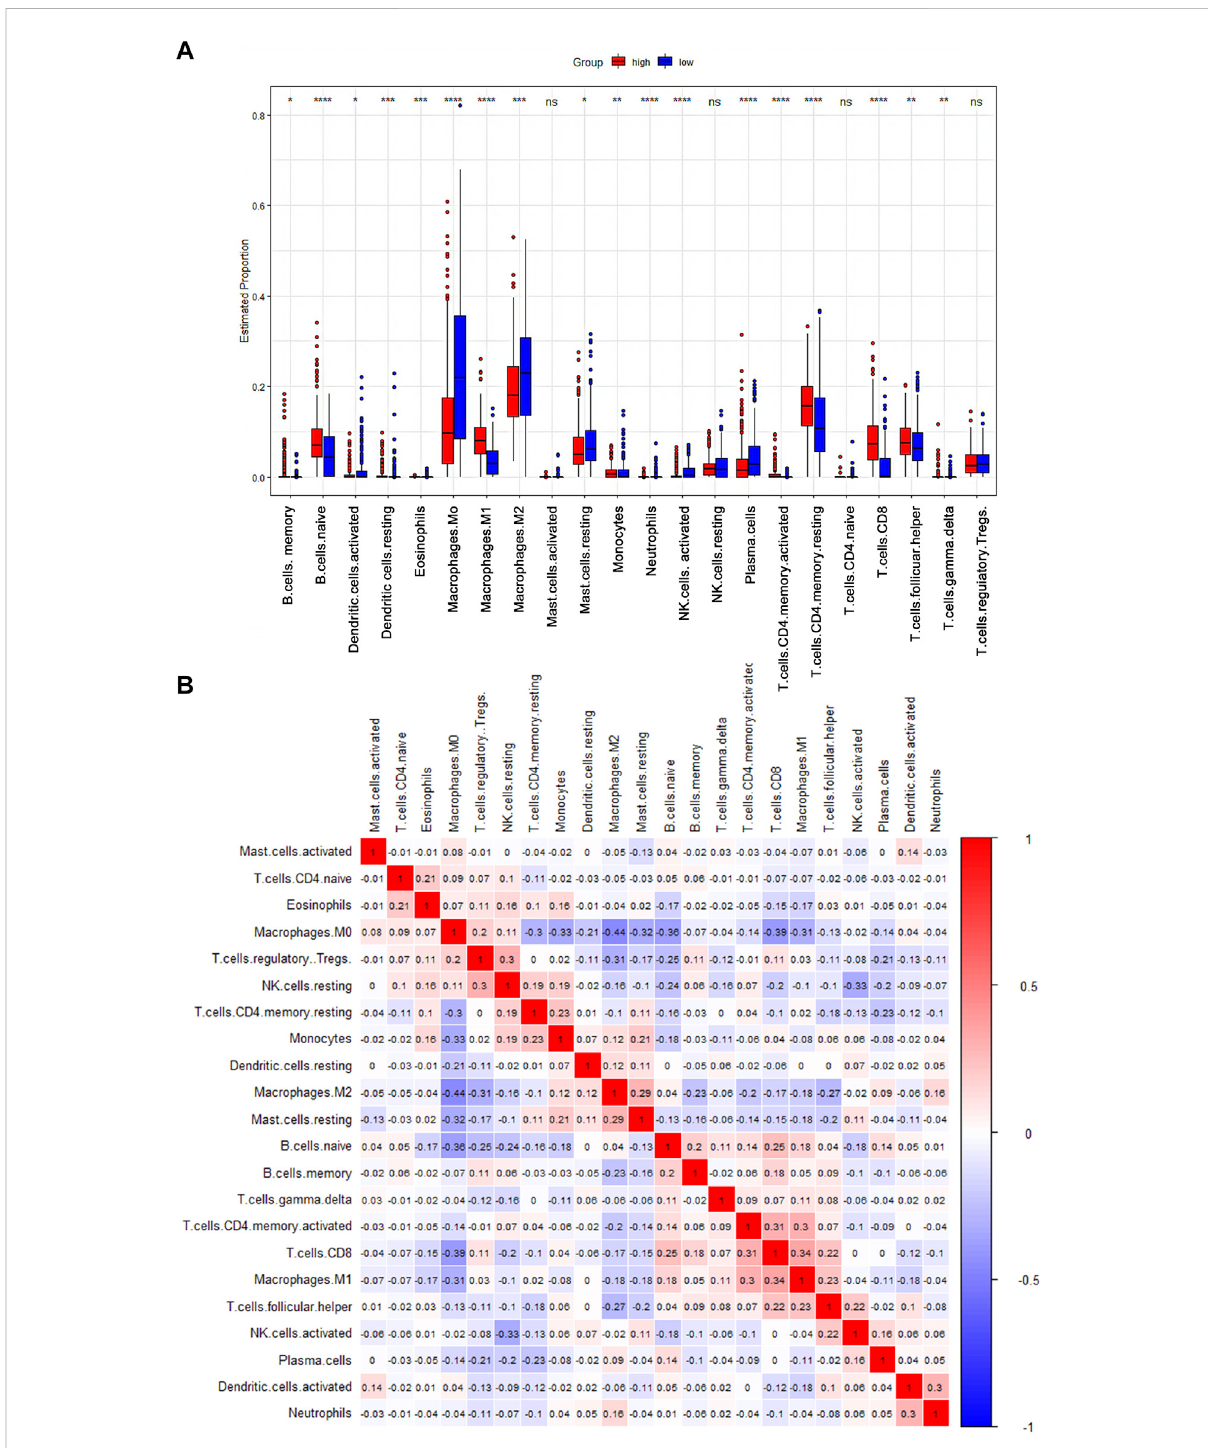
FIGURE 6 CIBERSORT analysis to evaluate thecorrelation between CD161 expressionand theimmune in fi ltration in BC. (A) The Boxplot showed the ratio differentiation of 22 kinds of immune cells between BC samples with high or low CD161 expression (red: high CD161 expression cohort; blue: low CD161 expressioncohort). * p < 0.05, ** p < 0.01,*** p < 0.001. (B) The correlation matrix showed therelevancebetweendifferentTILs proportions in BC. The correlation coef fi cients were exhibited on the colored squares (red: positive Spearman ’ s rho; blue: negative Spearman ’ s rho). TILs, tumor in fi ltrating